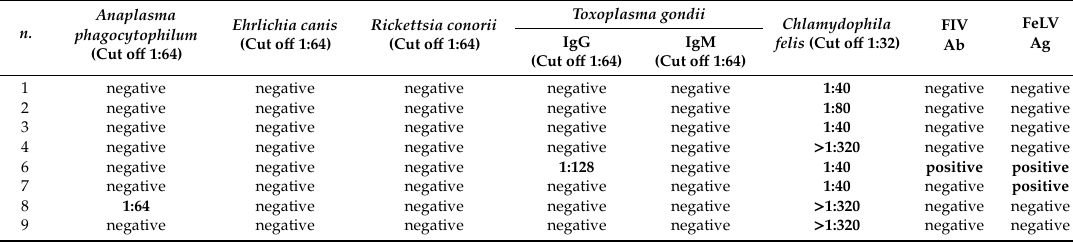
Table 8. Coinfections, retrovirus status and seroreactivity to immunofluorescence antibody test in L. infantum infected stray cats in Northern Italy. Due to insu ffi cient sample volume the end point titer for Chlamydophila felis was not